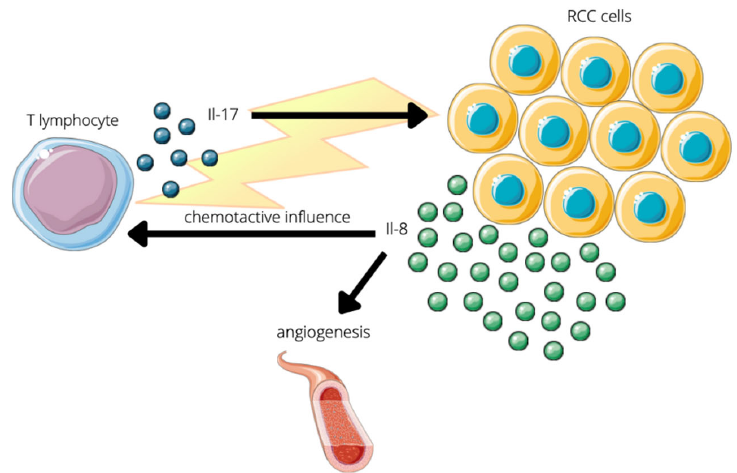
Figure 2. Schematic overview of the bidirectional influence between T ‐ lymphocytes and RCC. (1) T ‐ lymphocytes that were isolated from the RCC patient and incubated in special conditions, produce Il ‐ 17 in the presence of RCC cells. Il ‐ 17 triggers tumor cells to release a large amount of Il ‐ 8. This cytokine induces not only angiogenesis, but also has a chemotactive impact on T ‐ lymphocytes. (2) Consequently, the high number of lymphocytes T infiltrate RCC and tumors new vessels are created which is a favourable environment for tumor development.